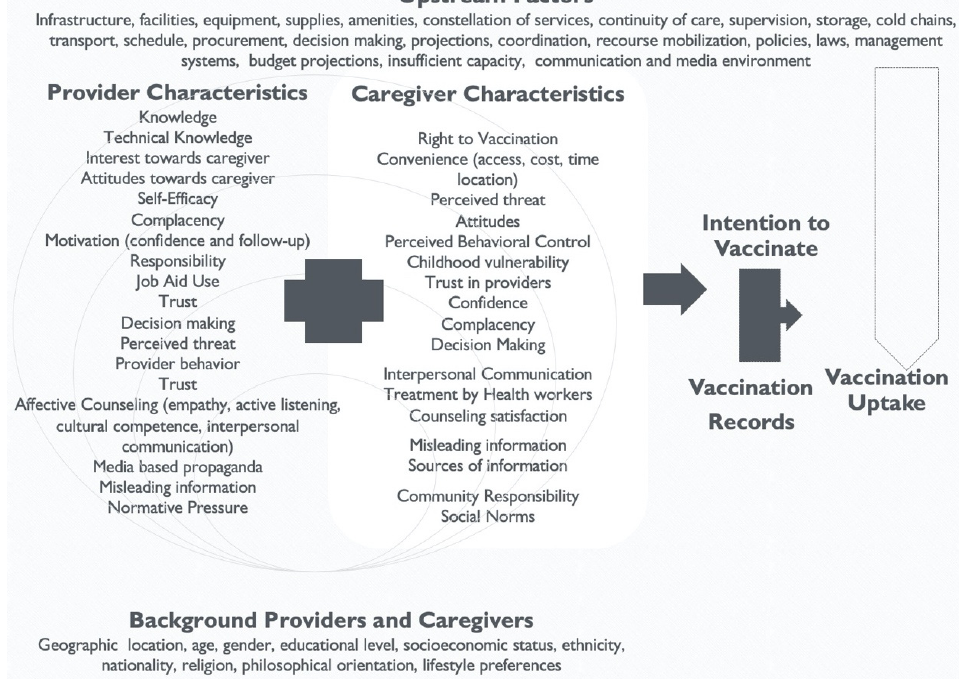
Figure 4. Providers and Caregivers Conceptual Model.